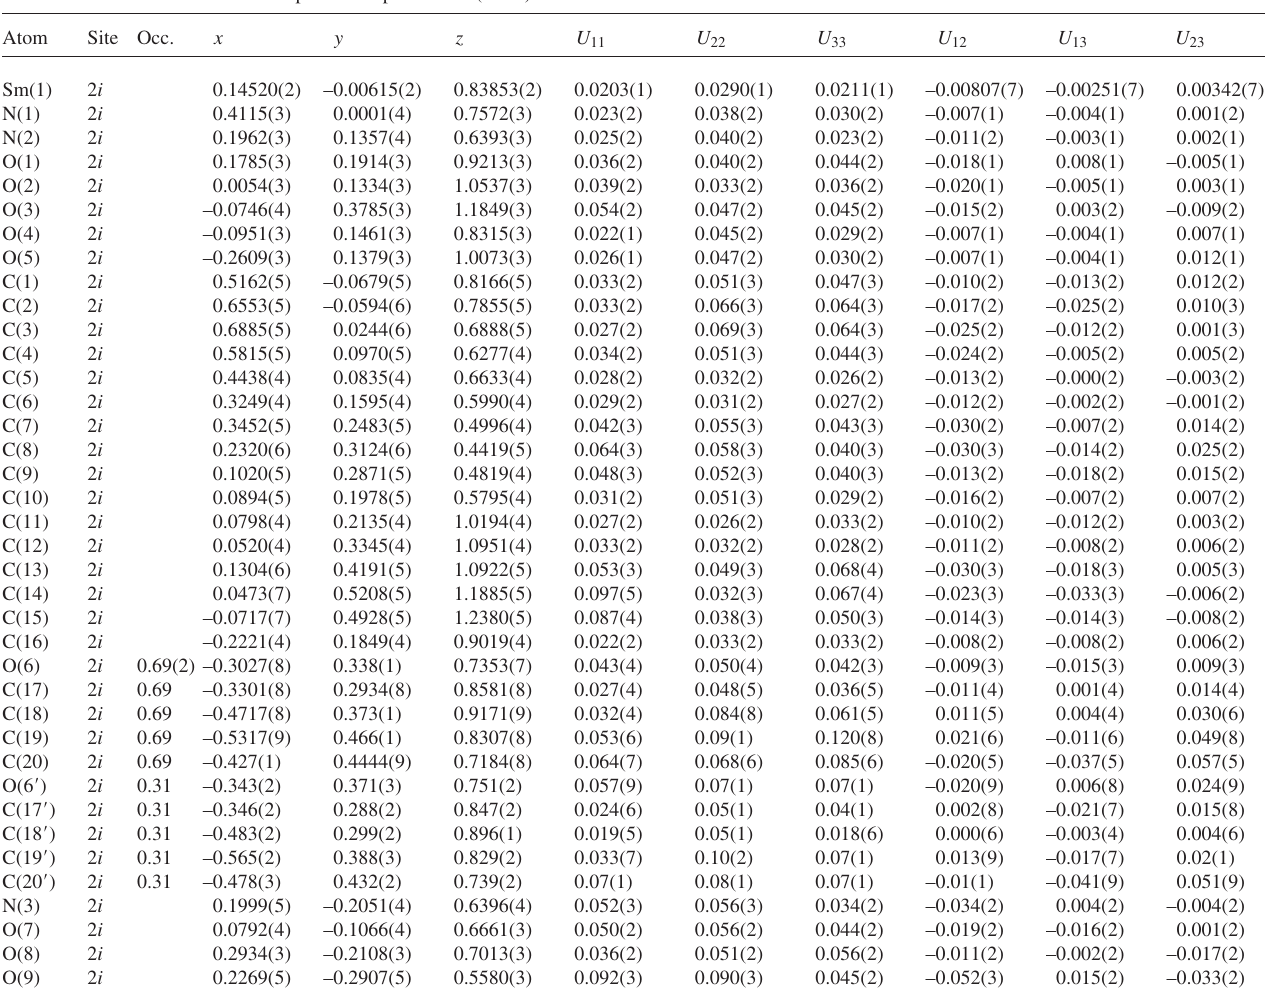
Table 3. Atomic coordinates and displacement parameters (in Å 2 )